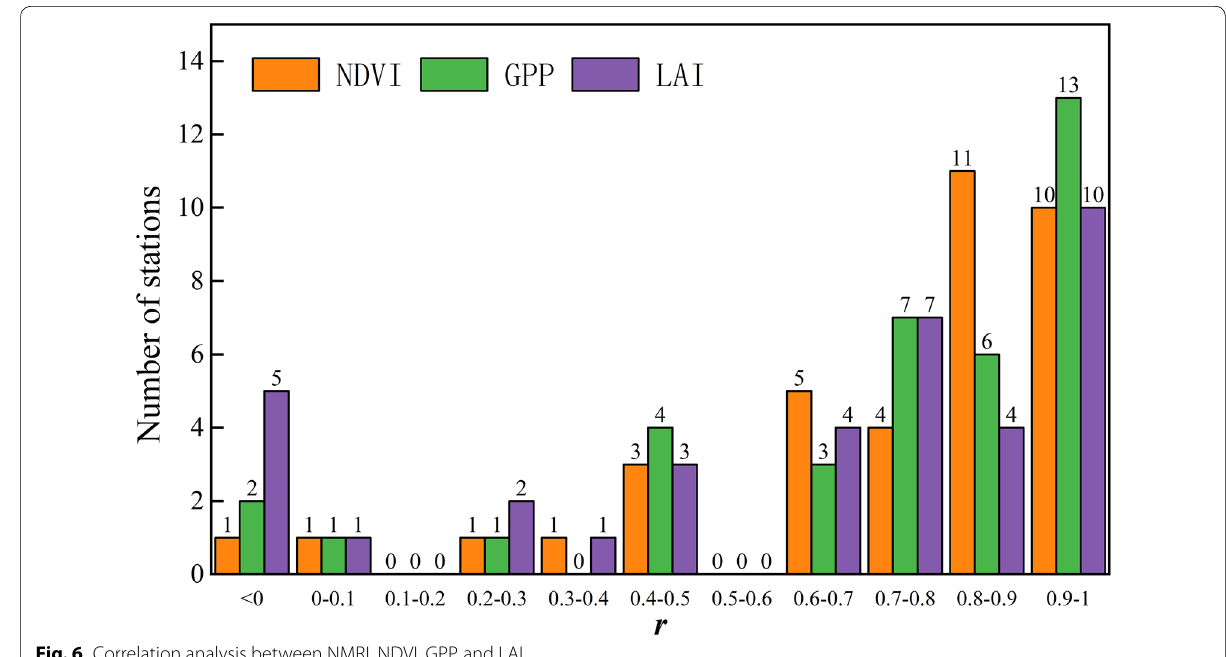
Fig. 6 Correlation analysis between NMRI, NDVI, GPP, and LAI